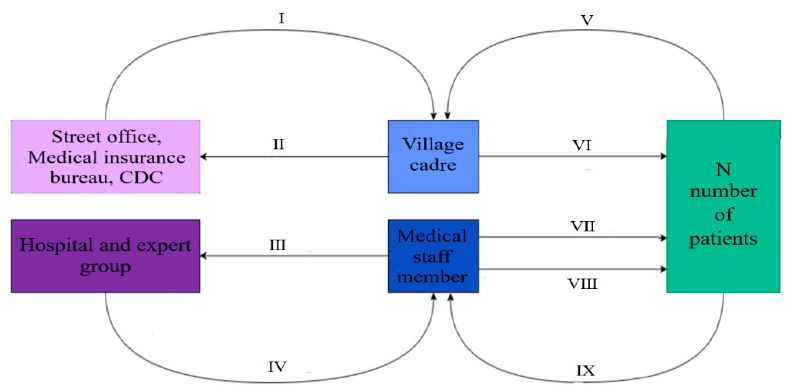
11 of 14 Figure 9. “Dean + Team” medical assistance pattern. Note: I Irregular rotation of medical teams; II Long-term treatment of critically ill patients; III Add new disciplines and opening new wards; IV Train medical assistance team; V Implement medical assistance projects. 4.2.2. Horizontal Medical Assistance of “1 Village Cadre + 1 Medical Staff + N Patients”